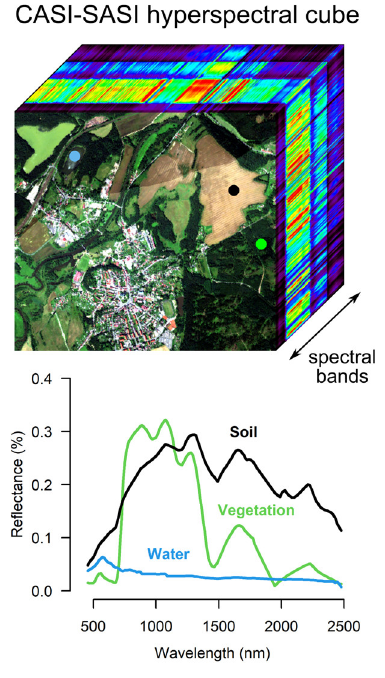
Figure 6. Data acquisition—an example of a CASI/SASI hyperspectral cube.